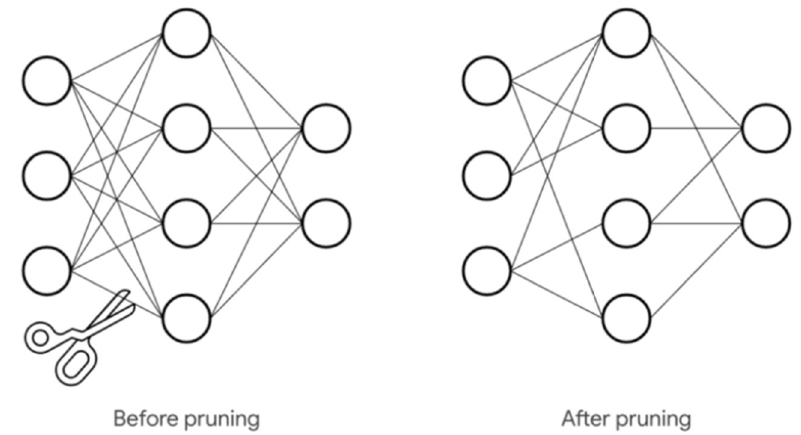
Figure 5. Pruning e ff ect on the Figure 5. Pruning effect on the network.